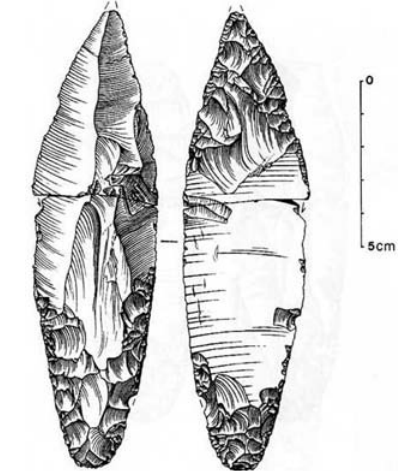
Figure 3 Blade point projectile of the LRJ from Beedings comprising two refitted elements along an impact break. Drawn by Hazel